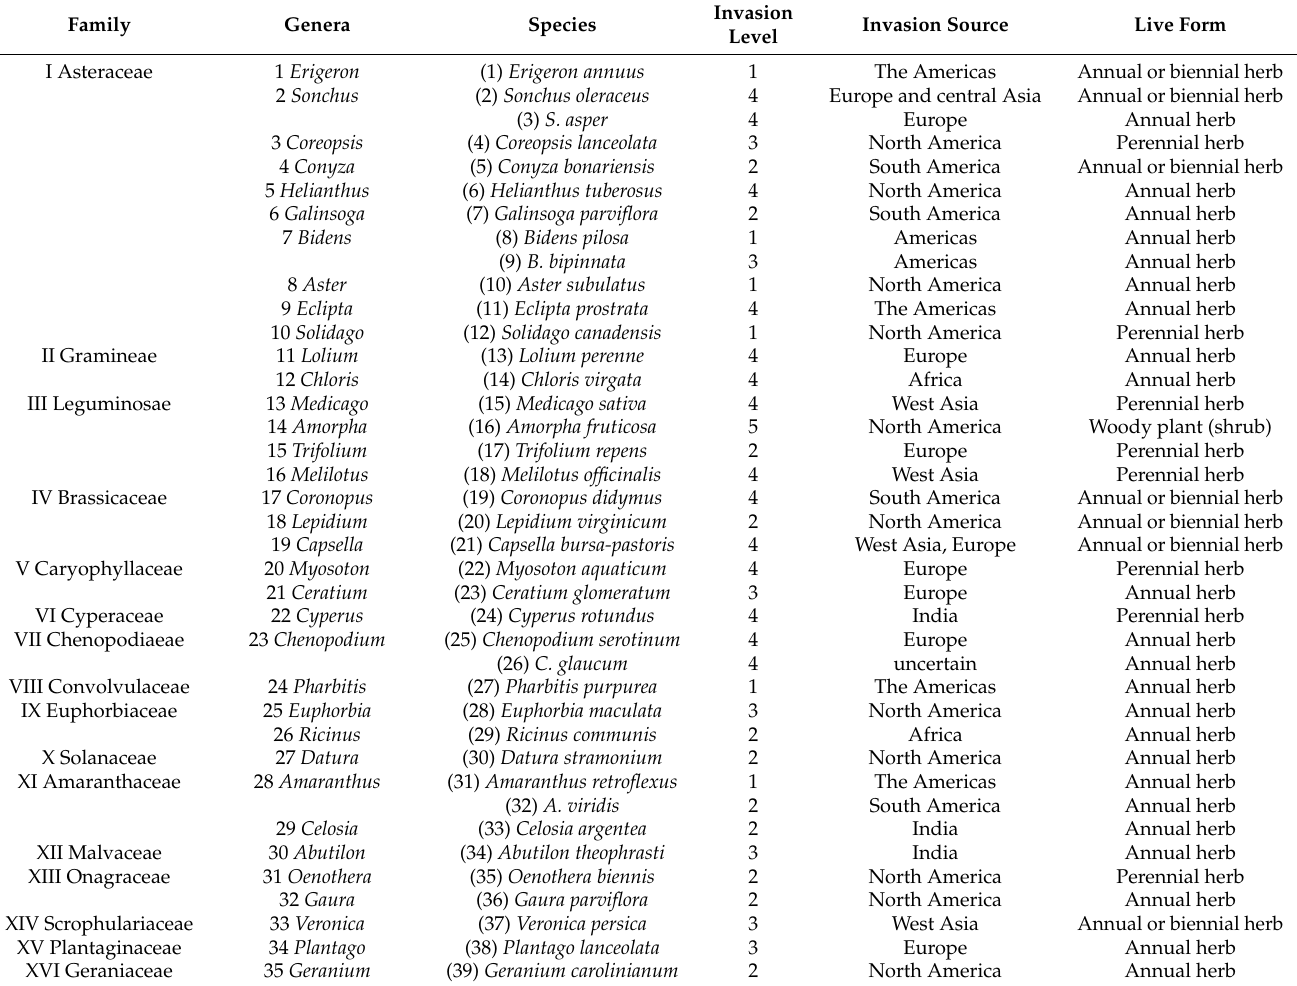
Table 3. Invasion level, invasion source, and life forms of alien invasive plants in the exhibition and education area of the Tangdao Bay National Wetland